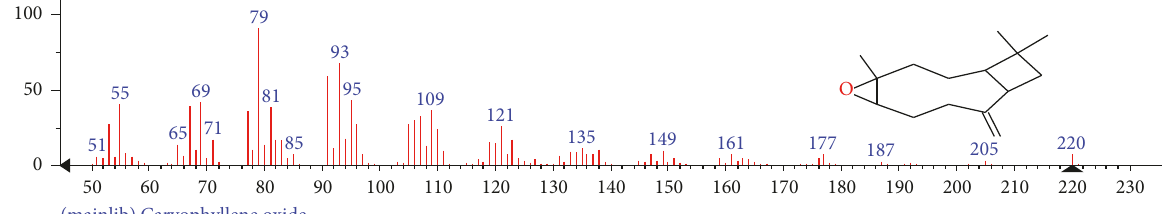
Figure 24: Mass spectrum of compound caryophyllene oxide of whole plant hexane fraction of Achillea wilhelmsii